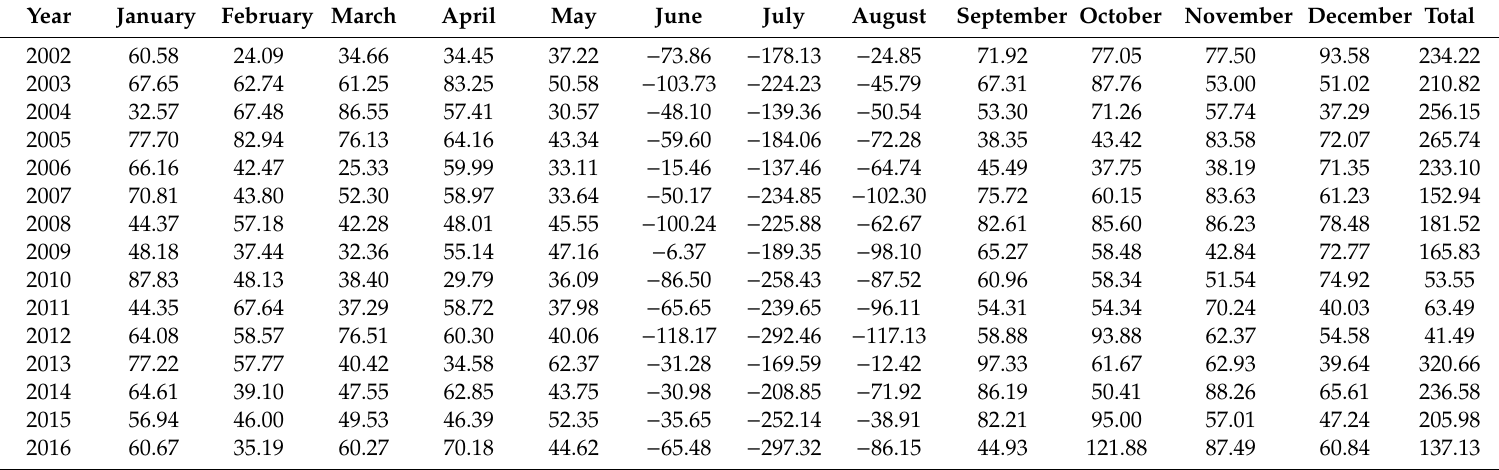
Table 1. The monthly surface mass balance from RACMO2.3 between 2002 and